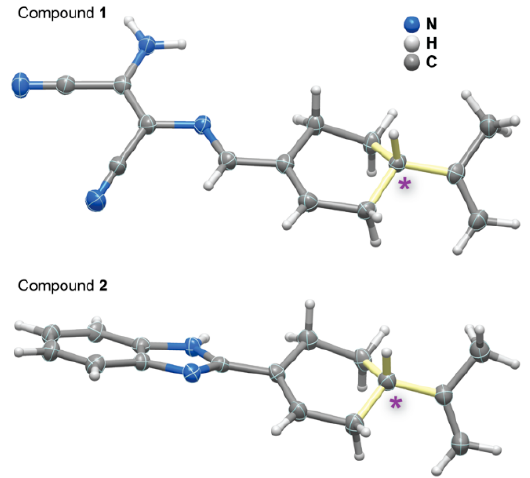
Figure 3. Schematic representation of molecular units present in the crystal structures of compounds 1 and 2 (note: the second identical molecule present in the asymmetric unit of 2 was omitted for clarity). Asymmetric carbon centres are depicted by an asterisk and the bonds in light yellow. Non-hydrogen atoms are represented as thermal ellipsoids drawn at the 50% probability level and hydrogen atoms as small spheres with arbitrary radii.